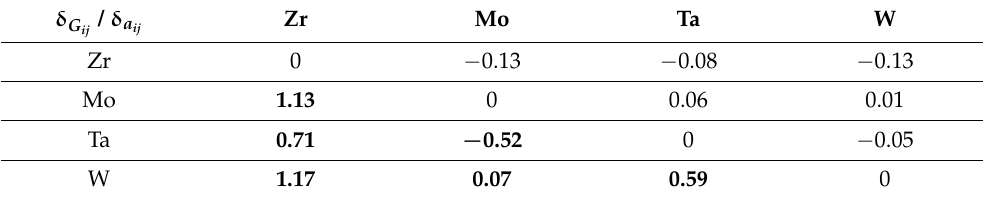
with bold numbers, of the alloying. ij